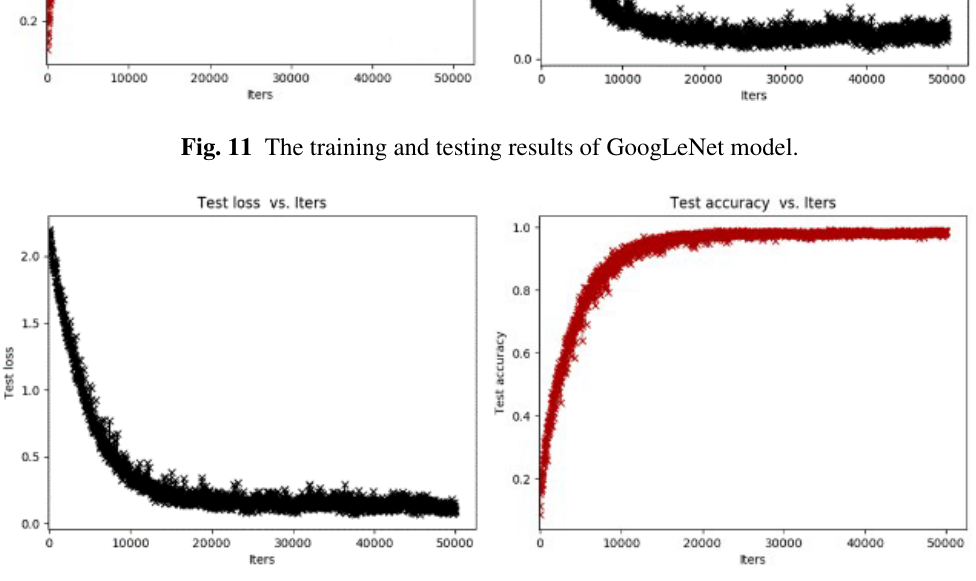
Fig. 12 The training and testing results of ResNet model.